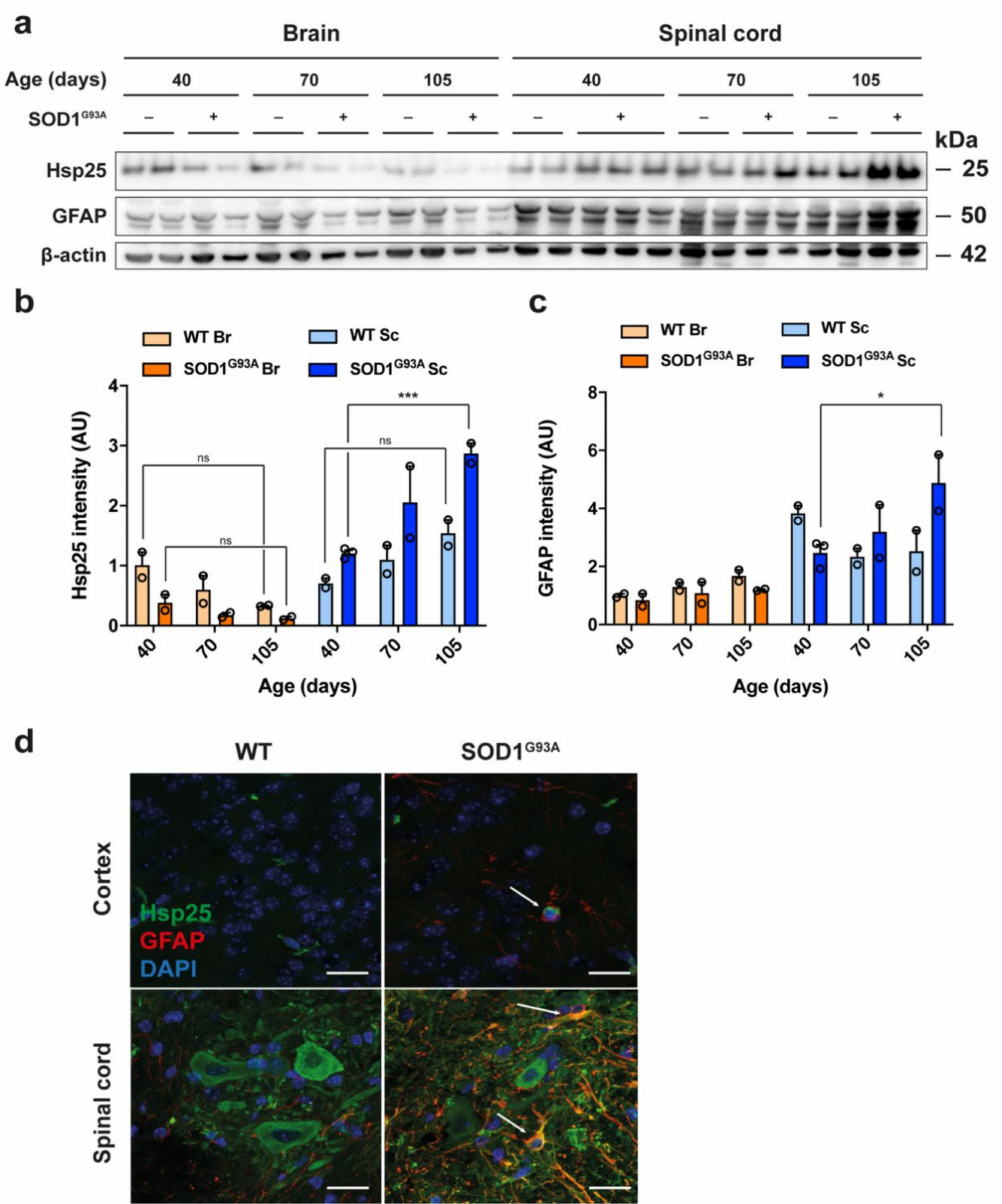
Figure 5. Hsp25 expression in the adult spinal cord and cortex of WT and SOD1 G93A mice. ( a ) Immunoblot analysis of Hsp25 and GFAP expression levels in whole brain and whole spinal cord lysates. ( b ) Quantification of Hsp25 and ( c ) GFAP expression in the brain and spinal cord of 40-, 75- and 105-day-old WT and SOD1 G93A mice. Data are displayed as the mean ± SEM of 2-3 biological replicates and analysed by two-way ANOVA with post hoc Tukey tests, where p < 0.05 (*) and p < 0.001 (***). ( d ) Immunofluorescence of layer V of the cortex and ventral horn spinal cord sections from 90 day old WT and SOD1 G93A mice. Scale bar: 20 µ